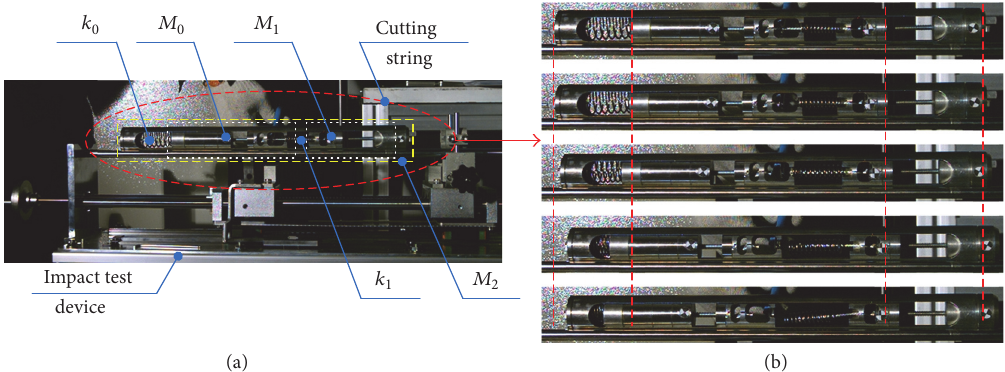
Figure 5: The test process of impact test device: (a) the preparatory work for the test; (b) experimental process of simulated penetrator.